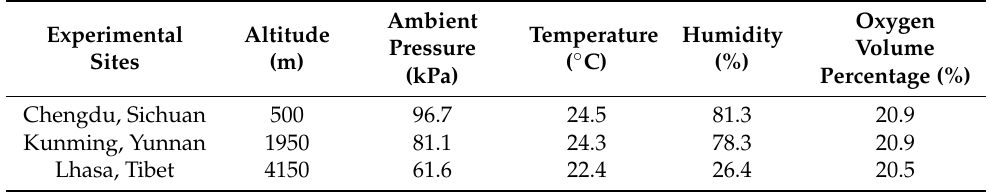
Table 3. Results of environmental parameters before experiments.